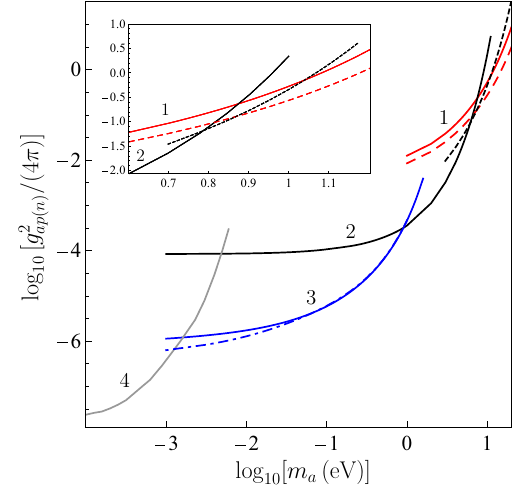
Fig. 3 Constraints on the coupling constants of axion-like particles to nucleons obtained in [20] from measuring the lateral Casimir force [23,24] ( line 1 ), in [19] from measuring the effective Casimir pressure [33,34] ( line 2 ), in [22] from the isoelectronic experiment [21] ( line 3 ), and in [16] from the Cavendish-type experiment [15] ( line 4 ). The long- dashed , short-dashed and dashed-dotted lines show the prospective constraints obtained in this work (see the text for further discussion). In the inset , the range of larger axion masses is presented on an enlarged scale. The regions of the plane below each line are allowed and above each line are excluded one arrives at stronger constraints on g an = g ap shown by the long-dashed line in Fig. 3. They are shown also in the inset to Fig. 3 on an enlarged